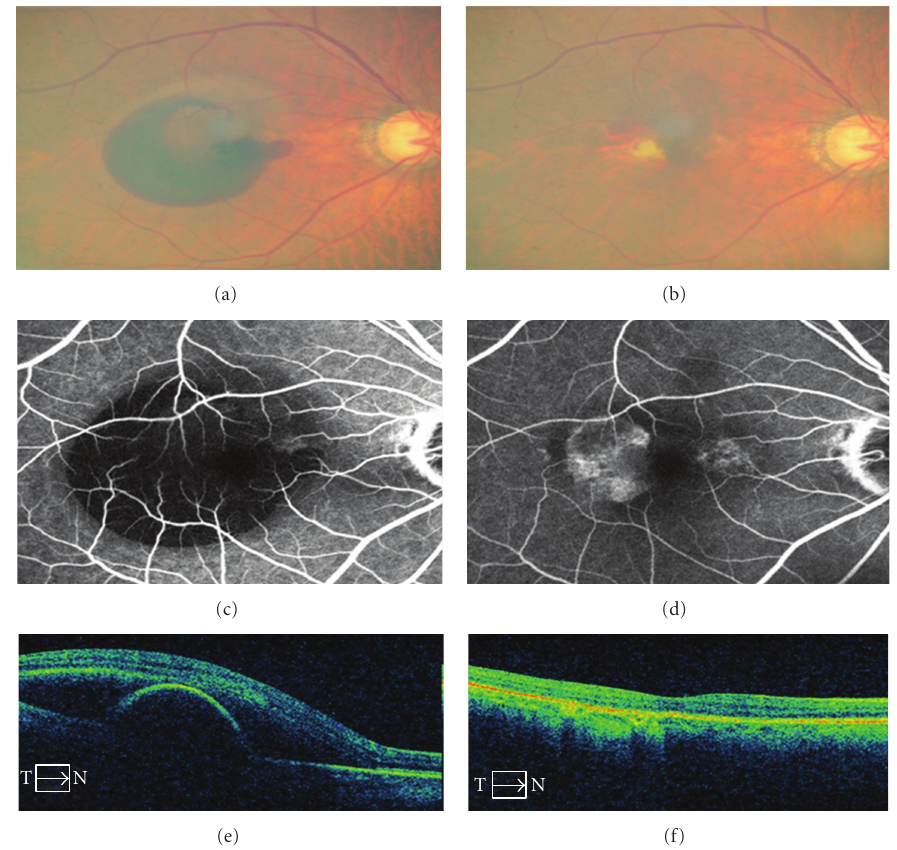
Figure 1: Fundus photograph of patients with hemorrhagic PED secondary to AMD. Fluorescein angiogram shows large hypofluorescence due to hemorrhage at macular lesion. Optical coherence tomography with large PED and subretinal fluid. (a, c, e) Same section after 3 rani- bizumab intravitreal injections. Complete resolution of the hemorrhagic PED with edema is illustrated. There was also improvement in visual acuity (b, d,